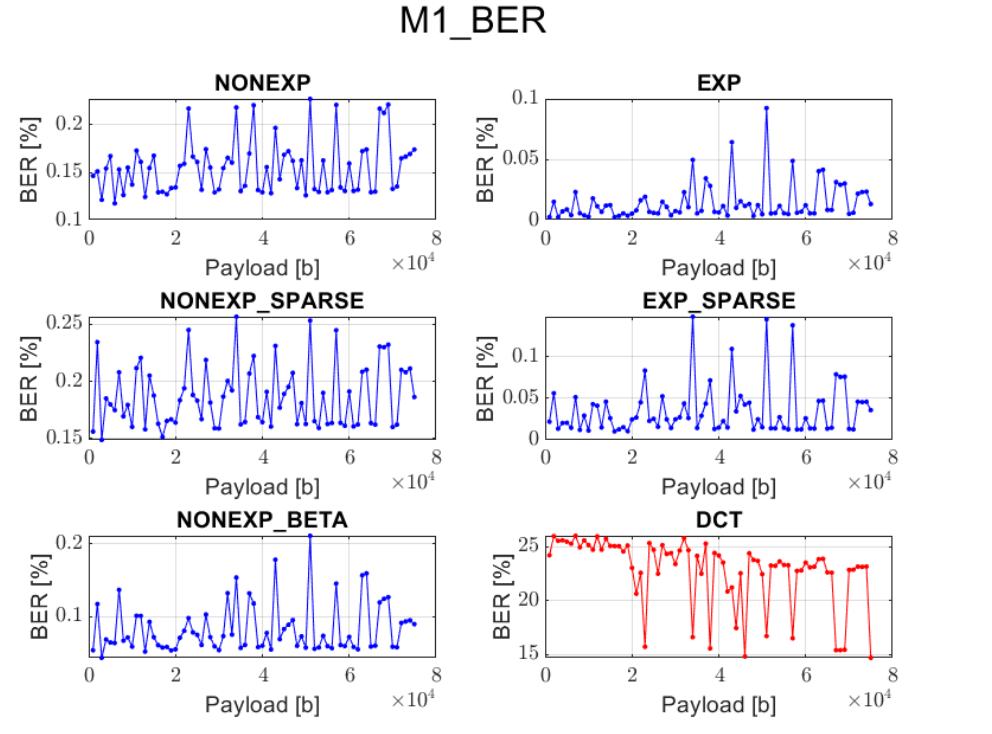
Figure 7. Relation between BER and embedded data size for method 1 and all transform